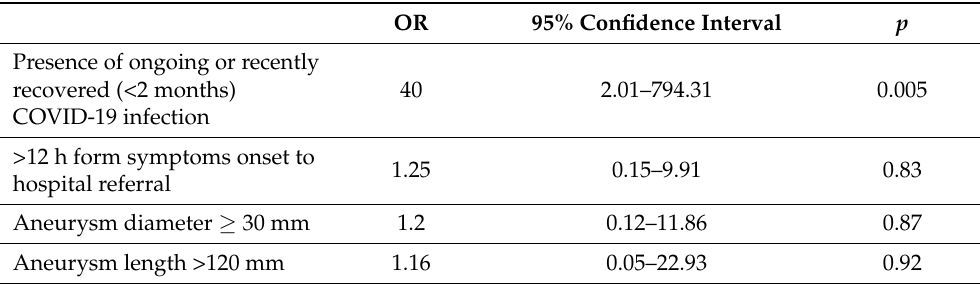
Table 4. Factors considered for statistical analysis as potentially affecting outcomes in 15 surgically treated symptomatic